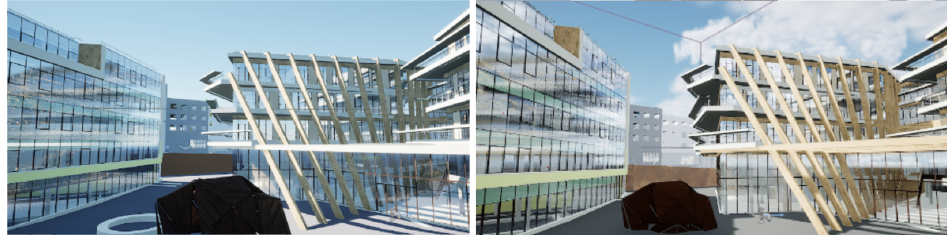
Figure 18. Before/after light